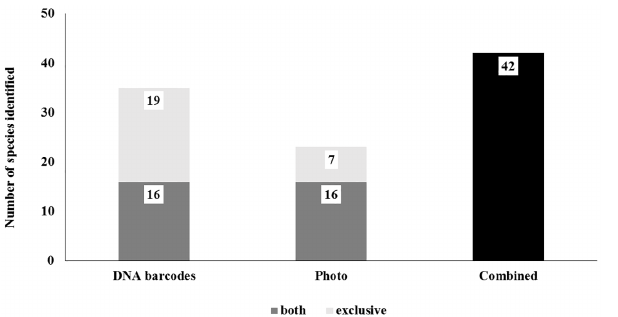
Fig 4. Number of species identified using DNA barcoding, photo identification and combined